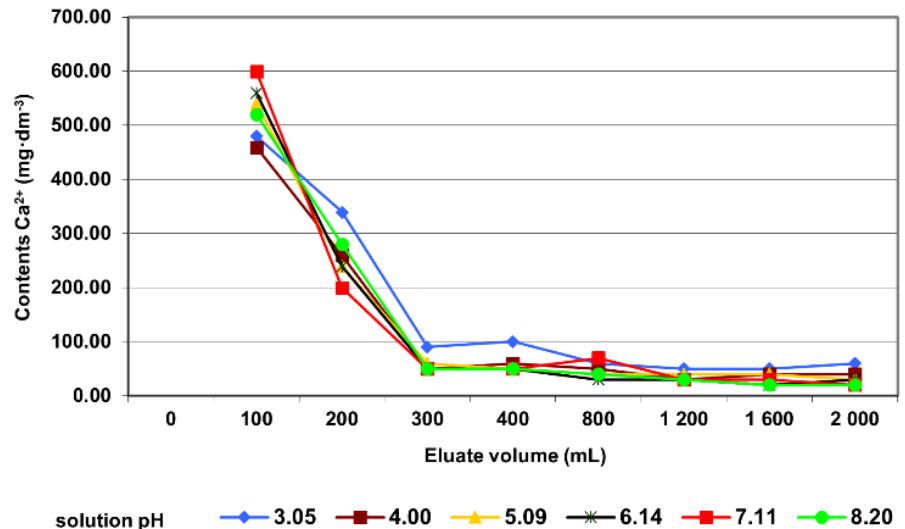
Figure 5. Contents of Fe 2+ ions in successive portions of the collected eluate depending on the pH of the initial leaching solution.